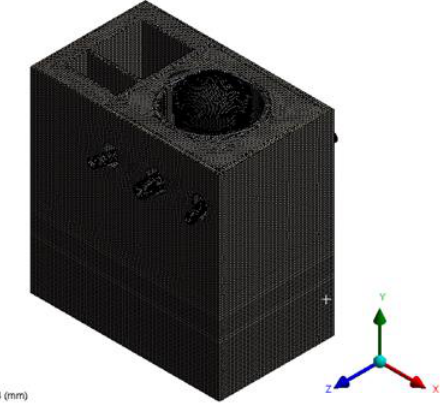
Figure 3. Finite element (FE) mesh for the reactor and the containment building.